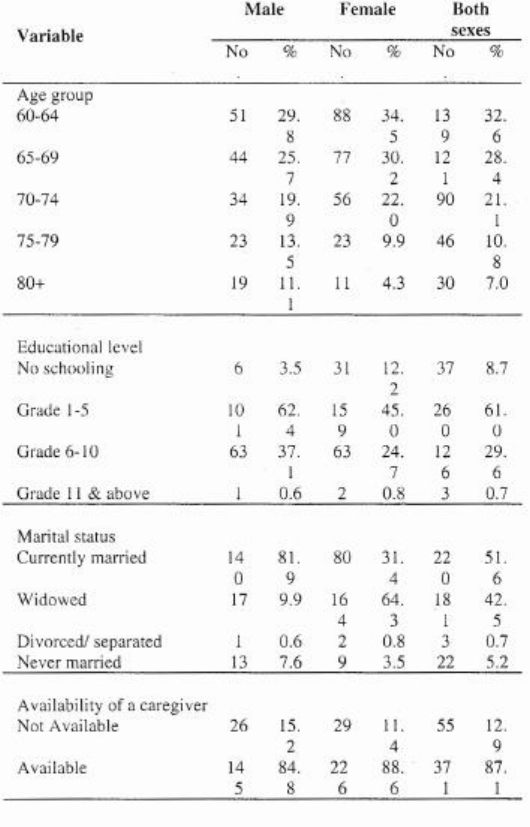
Table 2. Distribution of respondents by sex